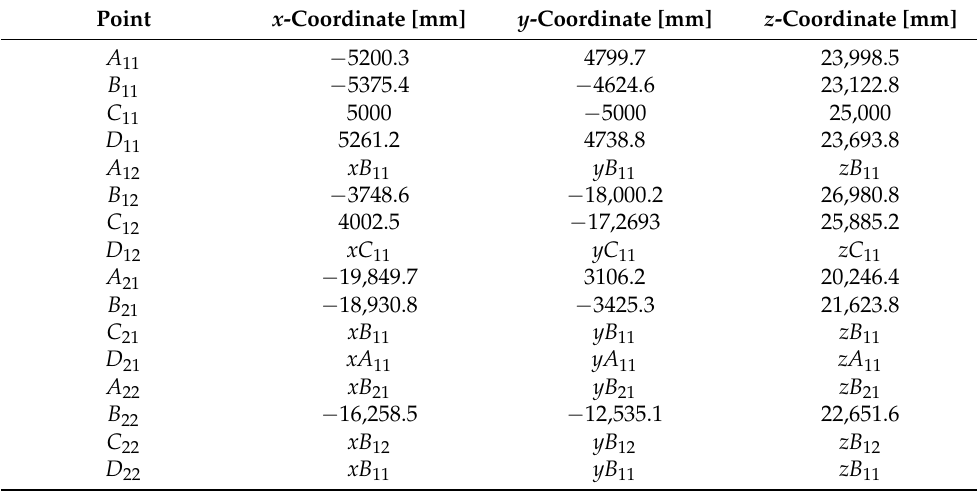
Table A4. The coordinates of the vertices A ij , B ij , C ij , D ij (for i , j = 1, 2) of the eaves edge net B v 1 (and the first structure Σ 1